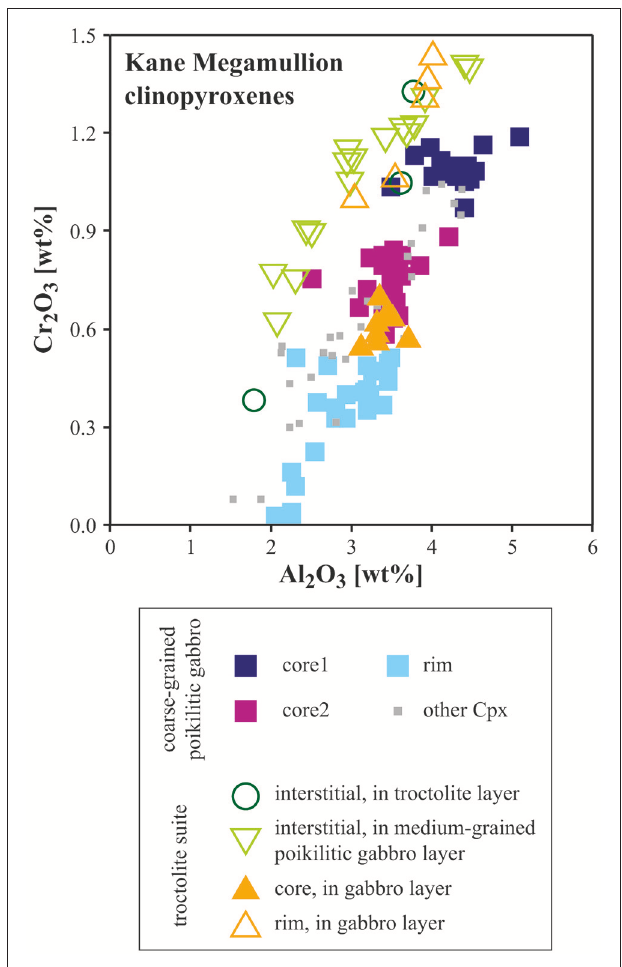
Figure 5 | Chemistry of Kane Megamullion clinopyroxene grains in the coarse-grained poikilitic gabbro and the troctolite, medium-grained poikilitic gabbro and gabbro